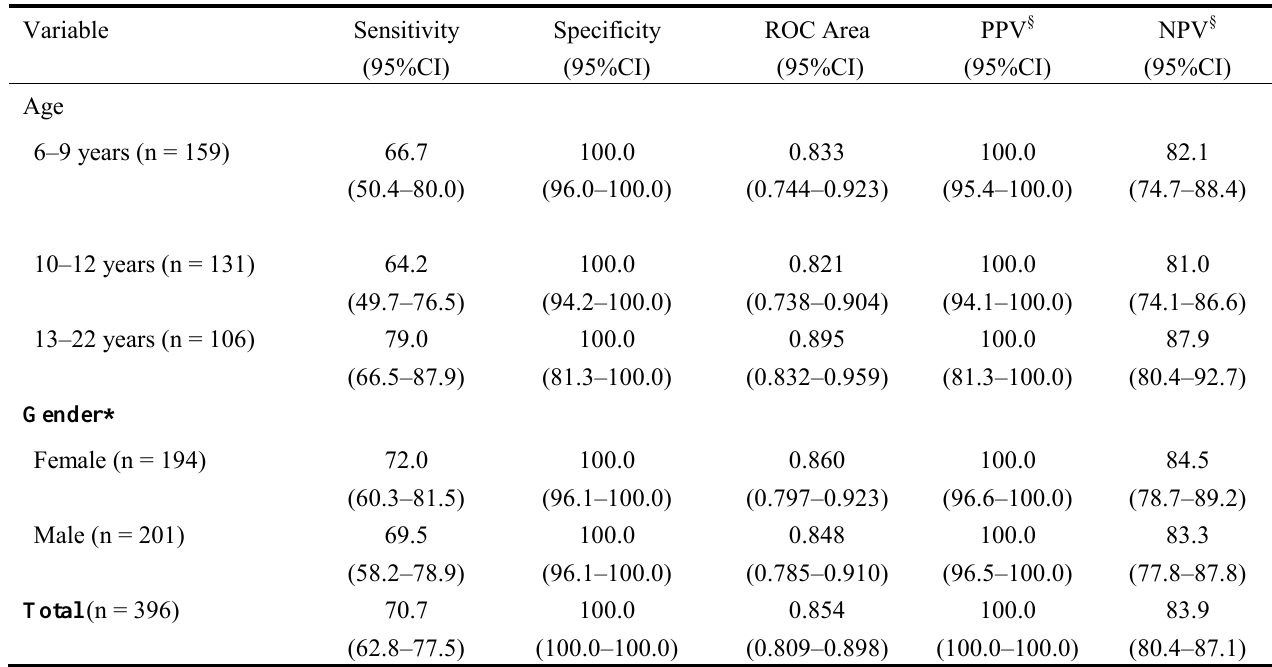
Table 6. Sensitivity, specificity, accuracy, positive and negative predictive values achieved using the simplified TF index to determine the prevalence of severe dental fluorosis (TF ≥ 5) when compared to the gold standard (full mouth TF index), rural communities,